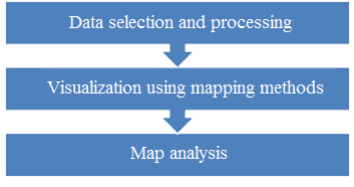
Fig. 1. Diagram of research